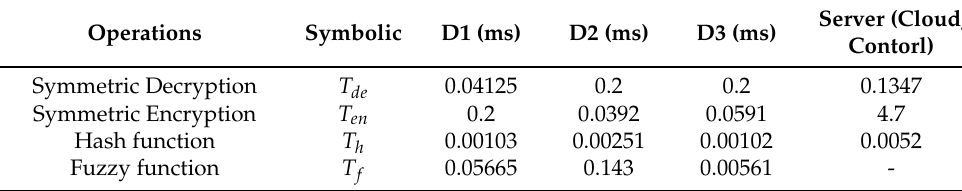
Table 4. The computational costs of complex operations.